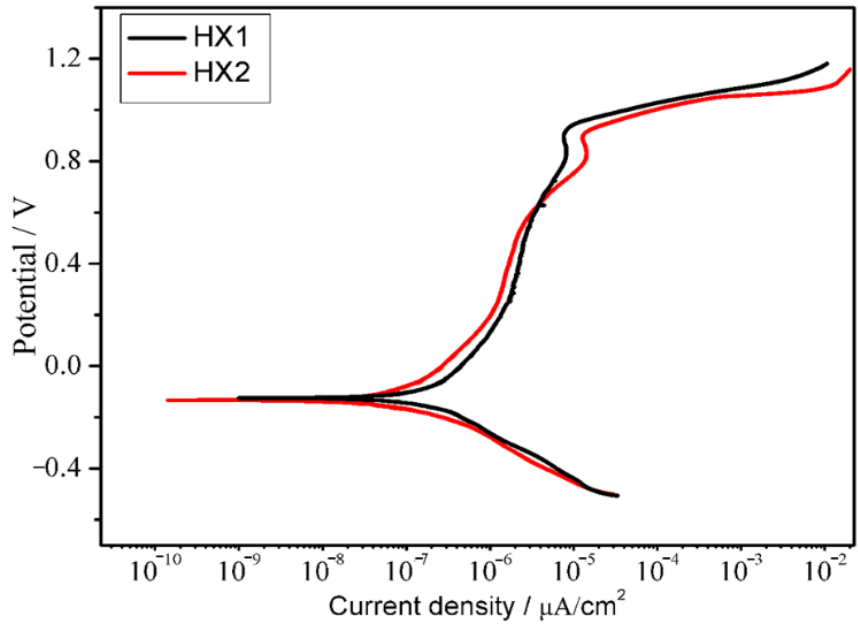
Figure 11. Polarization curve of the CoCrFeNiSiMoW MEACs in a 3.5% NaCl solution.